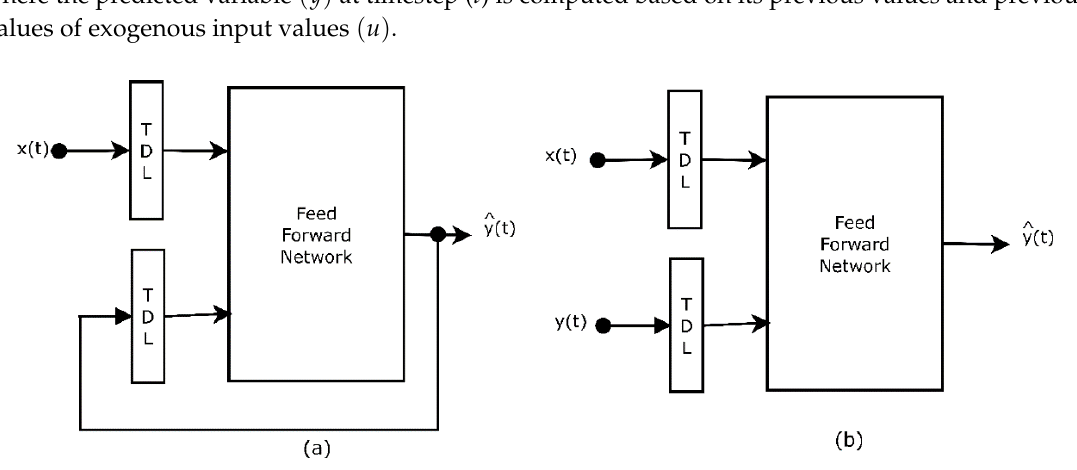
Figure 3. A typical NARX structure ( a ) parallel ( b ) series-parallel.